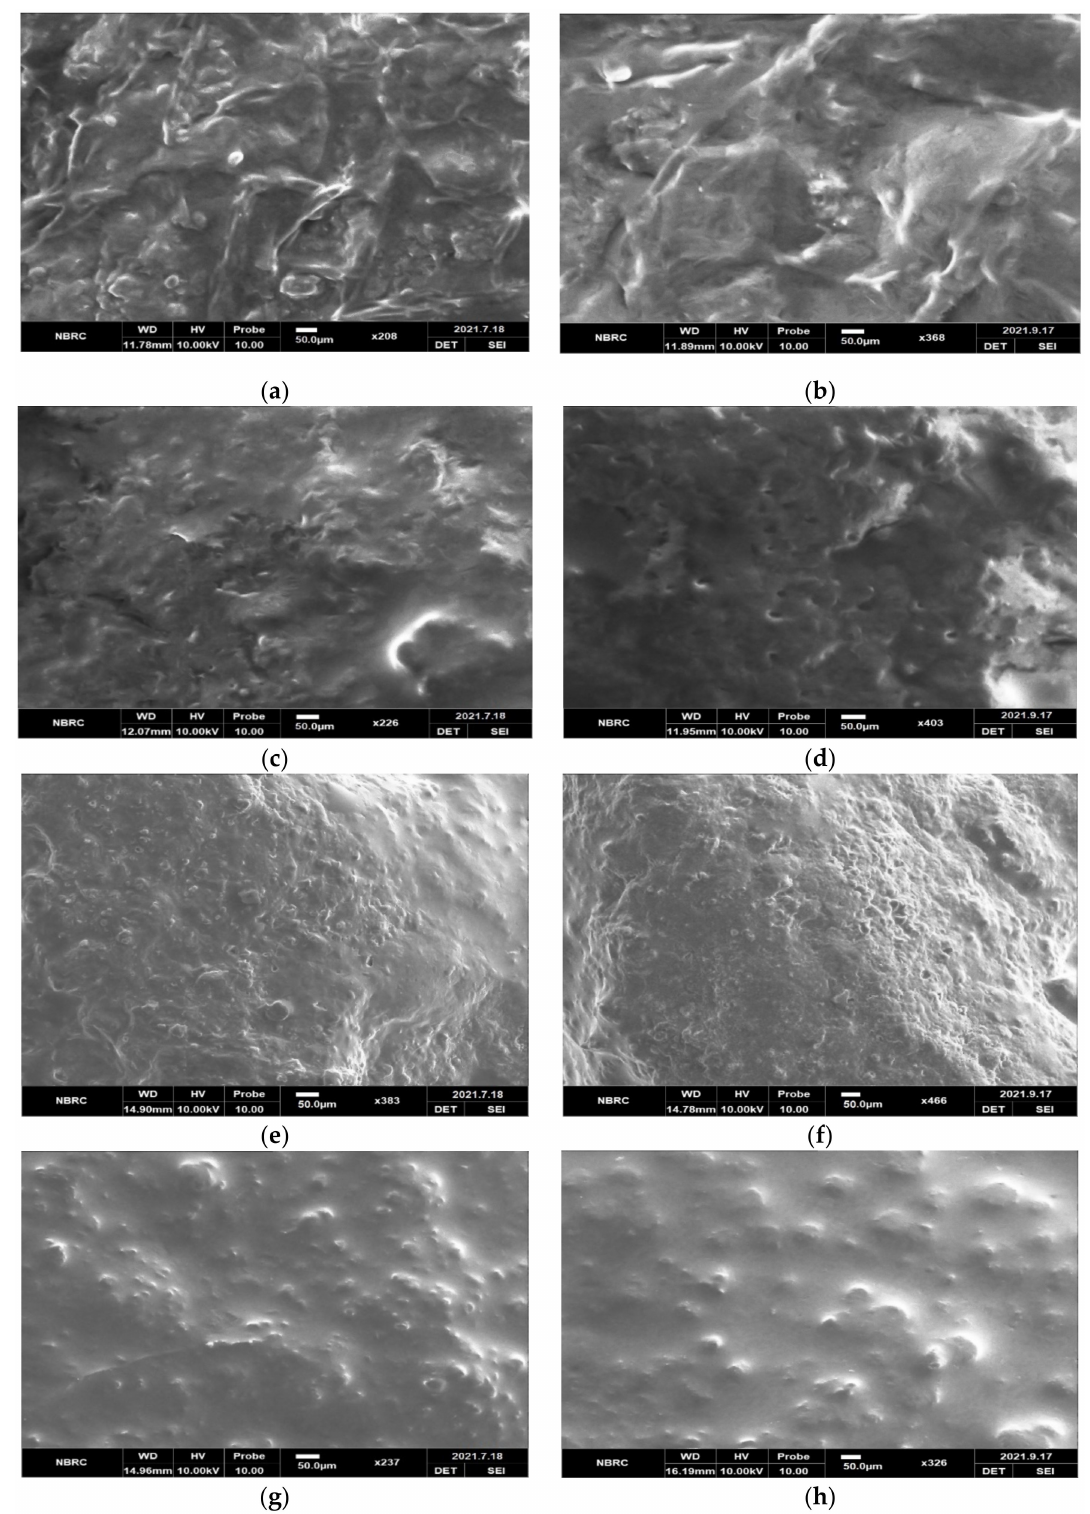
Figure 1. Scanning electron microscopy (SEM) images of cheese: ( a ) T 0 at 0 day; ( b ) T 0 at 60th day; ( c ) T 1 at 0 day; ( d ) T 1 at 60th day; ( e ) T 2 at 0 day; ( f ) T 2 at 60th day; ( g ) T 3 at 0 day; ( h ) T 3 at 60th